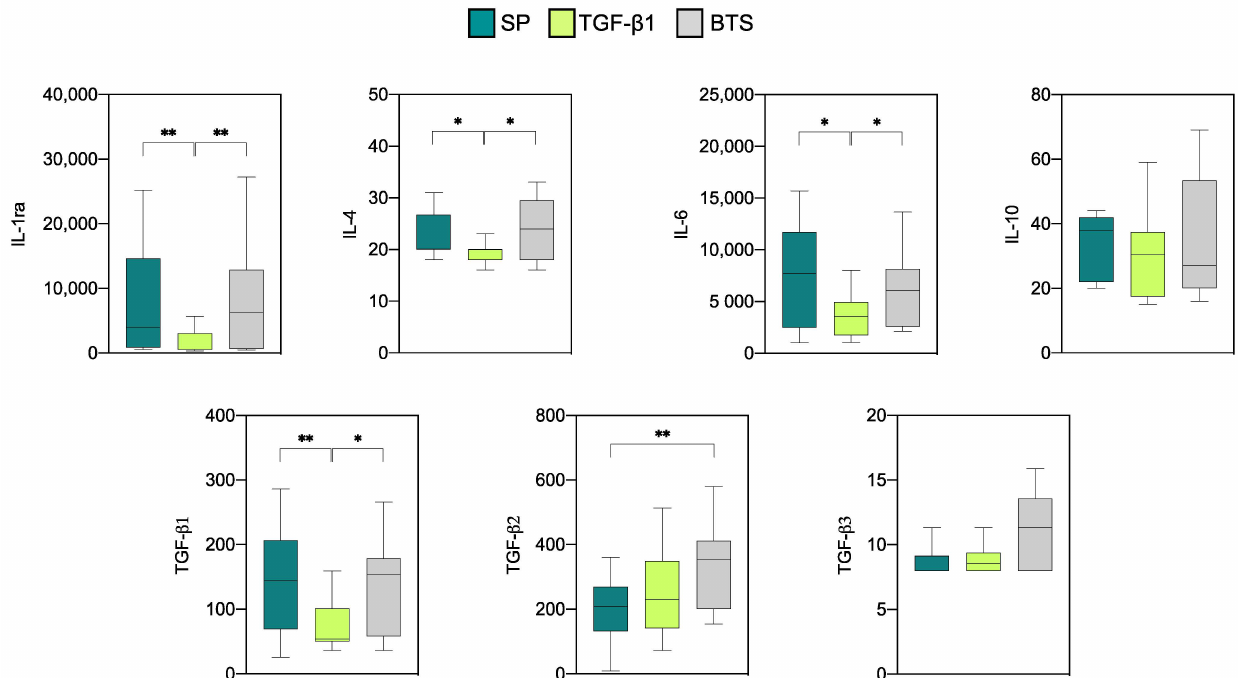
Figure 1. Levels of anti-inflammatory cytokines (pg/mL) on day 6 of pregnancy in endometrial explants of “donor” sows infused with 40 mL of SP, TGF- β 1 in BTS extender (TGF- β 1), or BTS alone (control) 30 min prior to each of two inseminations. The box plots show the median (line) and the interquartile ranges (boxes, Q1–Q3). * p < 0.05, ** p <